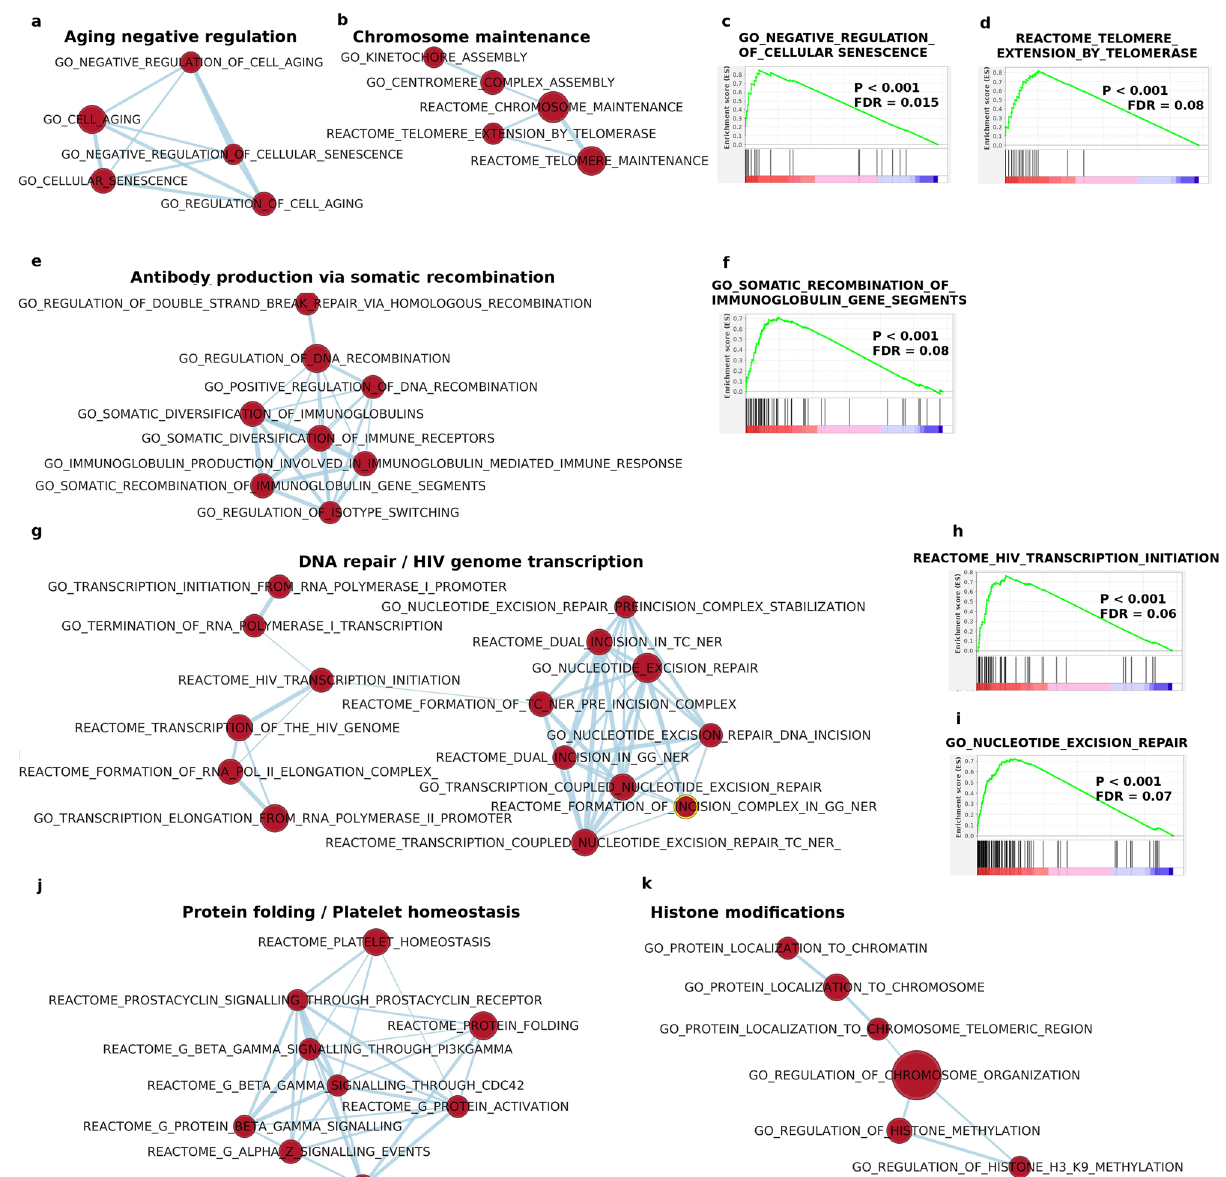
Figure 3. Impairment of several key pathways in ACE2 overexpressing cell lines. GSEA identified several gene sets downregulated in ACE2 overexpressing cell lines. Gene sets could be grouped in pathways/networks related to senescence/chromosome maintenance ( a – d ), antibody production ( e , f ), DNA repair/viral transcription ( g – i ), protein folding/platelet homeostasis ( j ), histone modifications ( k